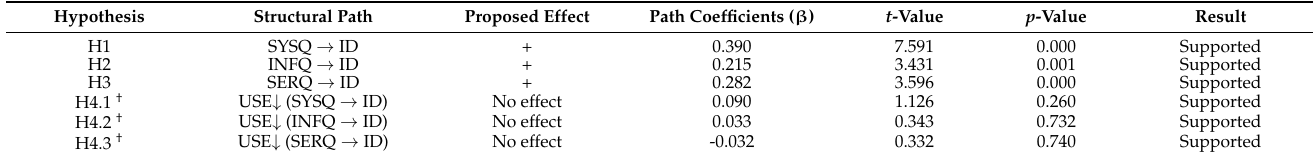
Figure 2. Results of main effects of PLS bootstrap estimation. Table 5. Summary of hypotheses testing results.